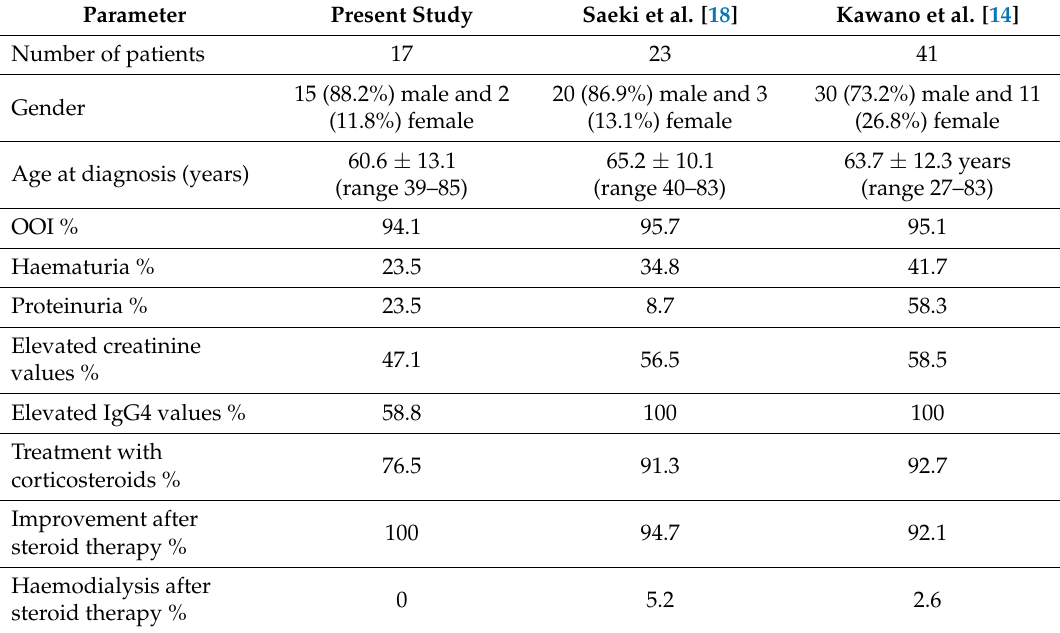
Table 3. Comparison of our results with studies from